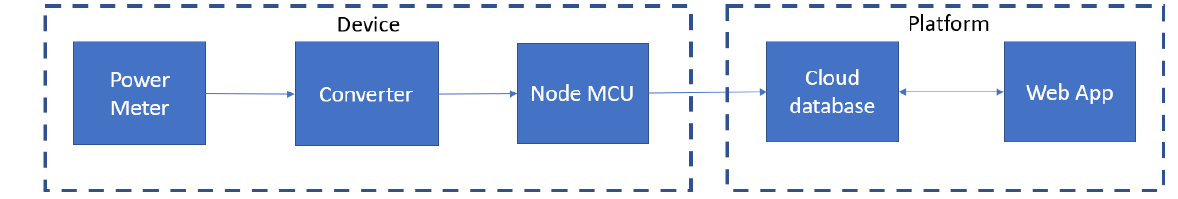
Figure 2. A power meter connects to the market platform.